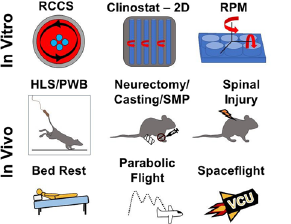
Fig. 1 Models for in vitro, in vivo, and fl ight methods for inducing microgravity. RCCS, Clinostat, and RPM methods use rotation to create vector averaged forces to simulate microgravity. Hind limb suspension (HLS), spinal injury, and single limb immobilizationvia casting, neurectomy, or skeletal muscle paralysis (SMP) limit the ground reaction forces on the limbs by completely unloading or inducing disuse to simulate microgravity, while only HLS induces a cephalic fl uid shift. Bed rest partially unloads the musculoskeletal system and induces a cephalic fl uid shift when used in conjunction with head-down tilt. Parabolic fl ight uses rapid descent to reduce ground reaction forces and momentarily simulate microgravity. Real space fl ight removes ground reaction forces, mechanically unloading the sample or subject, and creates a cephalic fl uid shift within the